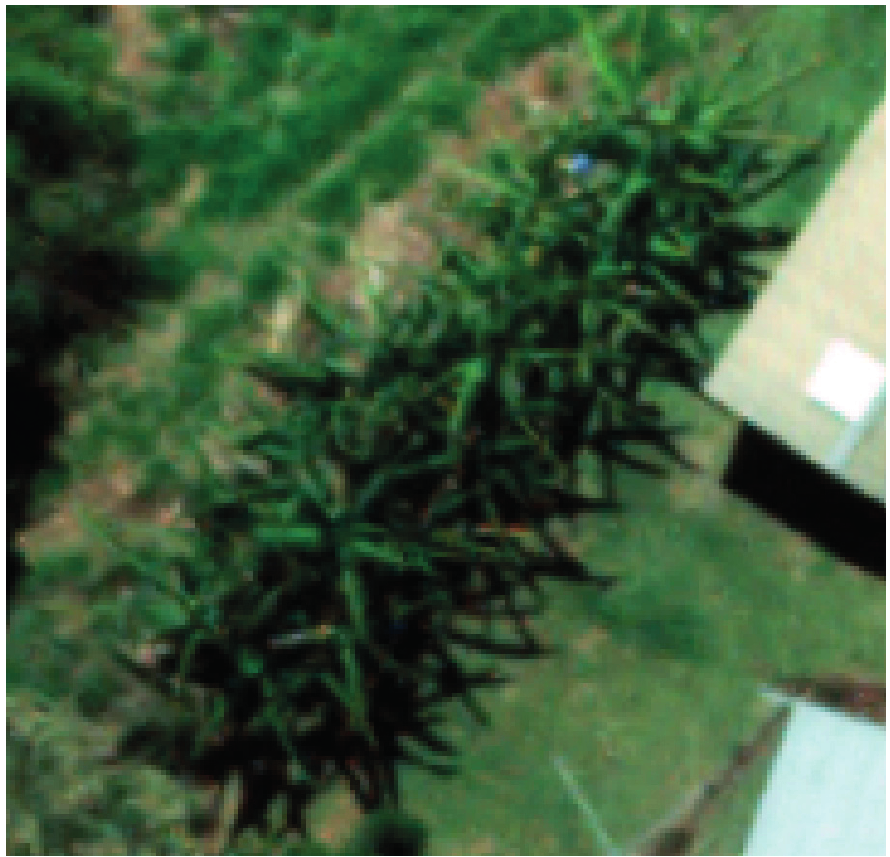
Figure 4. Orthophoto of banana plants showing the star shape of the leaves and their associated shadows on the ground spatially “in touch” in the photo with the actual